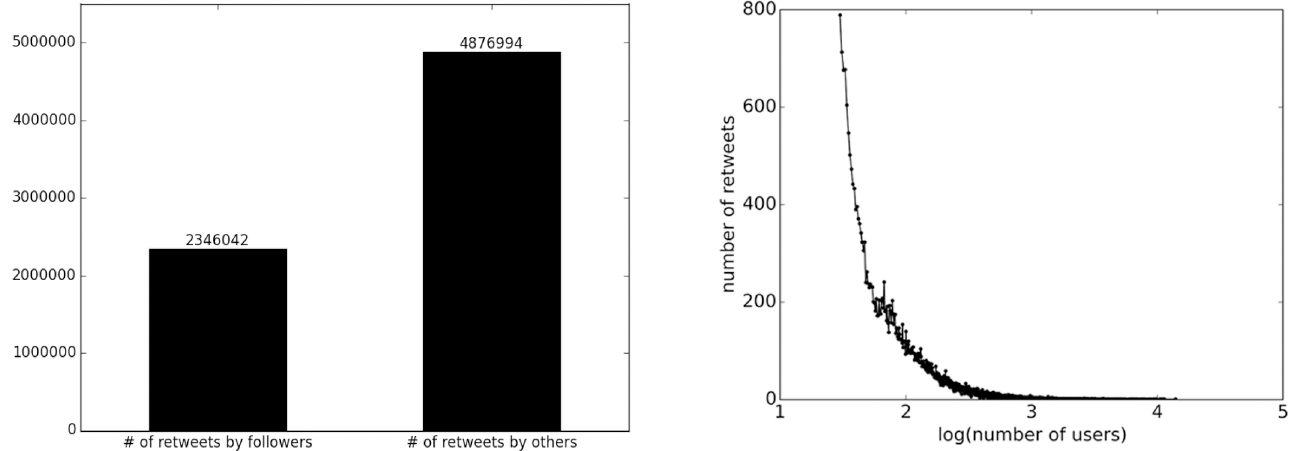
Fig 1. The statistics of Weibo data. (a) the retweet source distribution, (b) the number of retweets distributed over log(number of